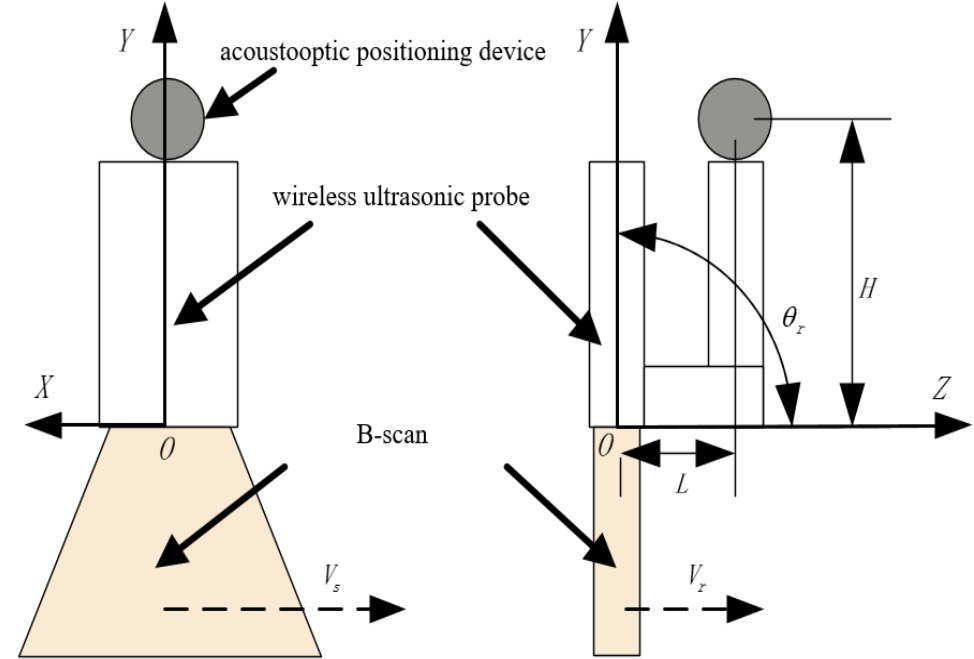
Figure 10. Coordinate conversion of ultrasonic image.